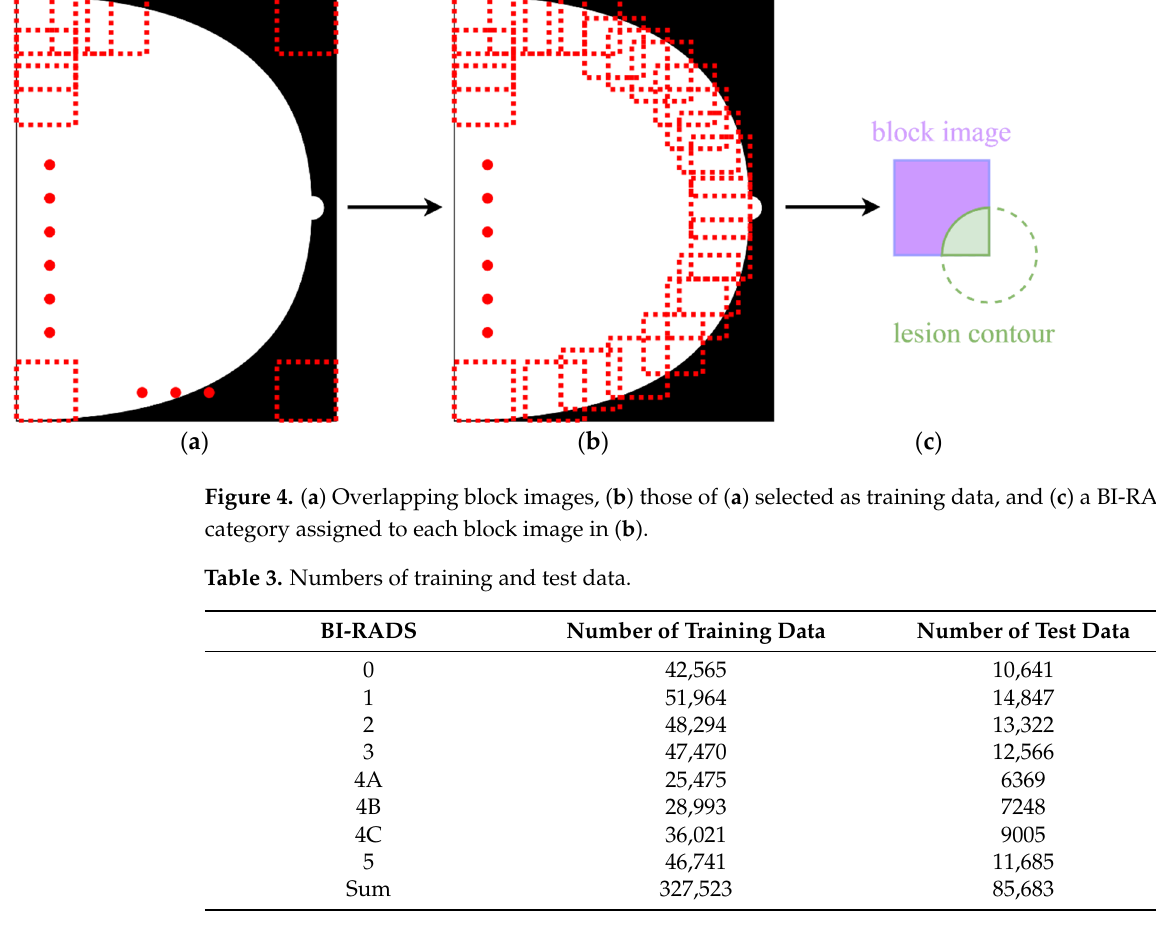
Table 3. Numbers of training and test data.